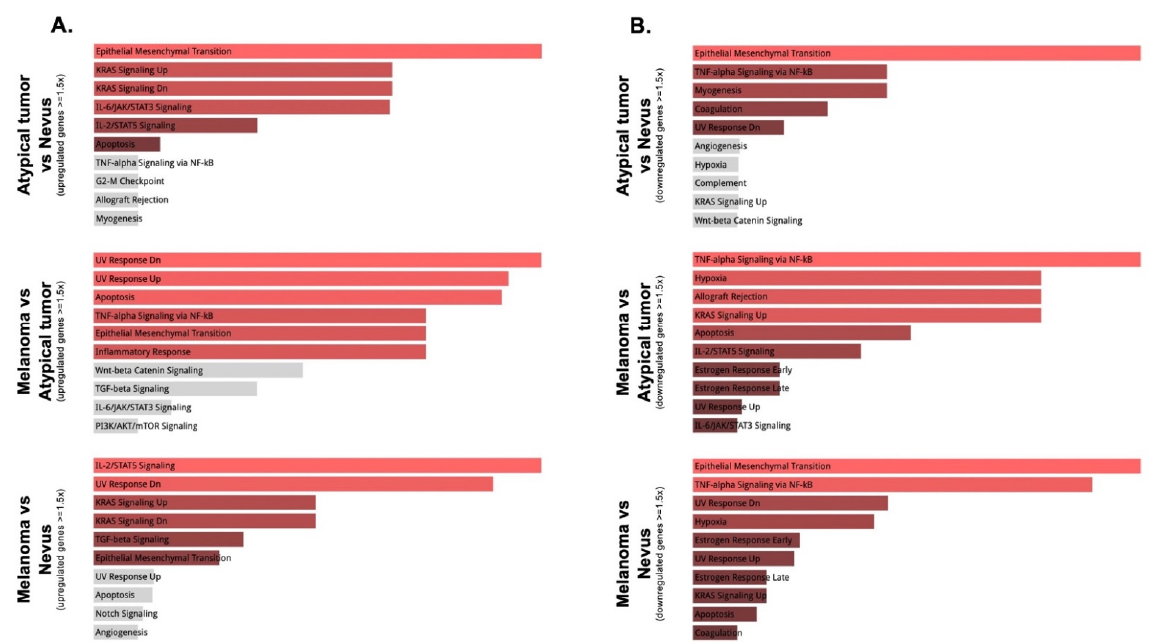
Figure 4. Gene enrichment analysis using the EnrichR platform. Upregulated ( A ) and downregulated ( B ) pathways (in the Hallmark category) in the following comparisons: Atypical tumor versus Nevus; Melanoma versus Atypical tumor; and Melanoma versus Nevus. Statistical significantly enriched terms are displayed in red, while gray bars are not statistically significant.